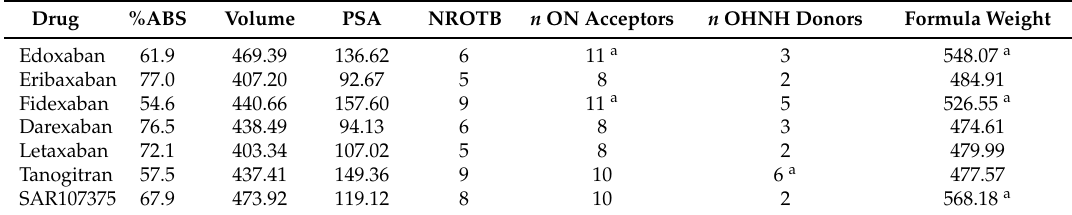
Table 5. Calculated absorption (%ABS), polar surface area (PSA) and Lipinski parameters of the anticoagulants